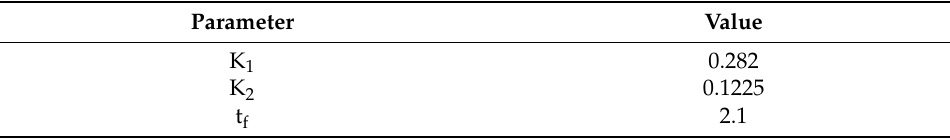
Table 2. Active damping function design